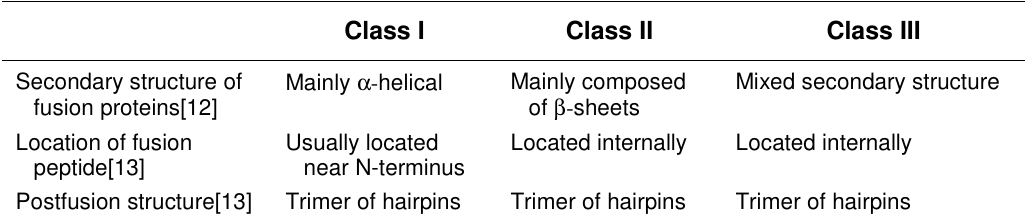
Properties of Class I, II, and III Fusion